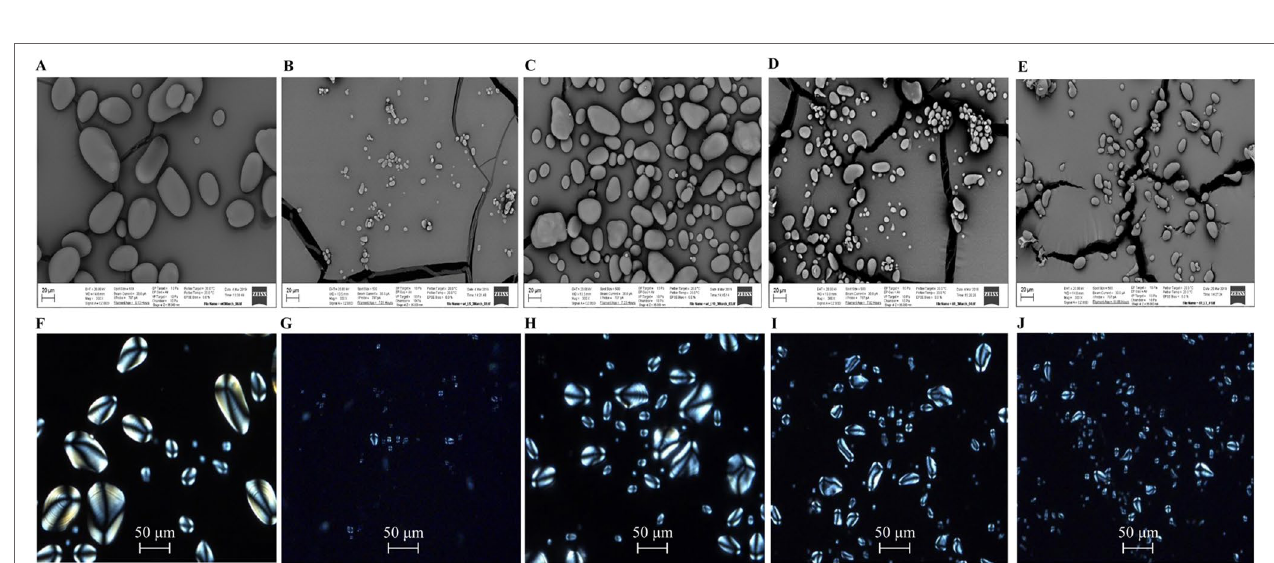
FigURE 9 | Microscopic observation of starch granules in mature potato tubers. (A) scanning electron microscopy (SEM) image of WT; (B) SEM image of WT-L5; (c) SEM image of WT-L10; (D) SEM image of HO69; (E) SEM image of 69-L3; (F ) Polarized light image of WT; (g) Polarized light image of WT-L5; (h) Polarized light image of WT-L10; (i) Polarized light image of HO69; (J) Polarized light image of 69-L3. The starch granules were observed under a view of 300× magnification in the SEM, with scale bars located in the lower left corner for each photograph. Sizes of the scale bars are all normalized to 20 μm. For the images taken by light microscopy, the scale bars are located in the lower middle position of each photograph. Size of the scale bars are normalized to 50